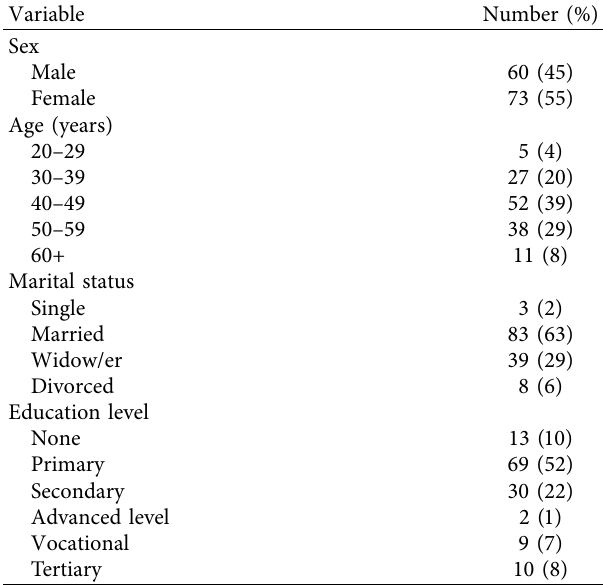
Table 1: Participants’ demographics in this